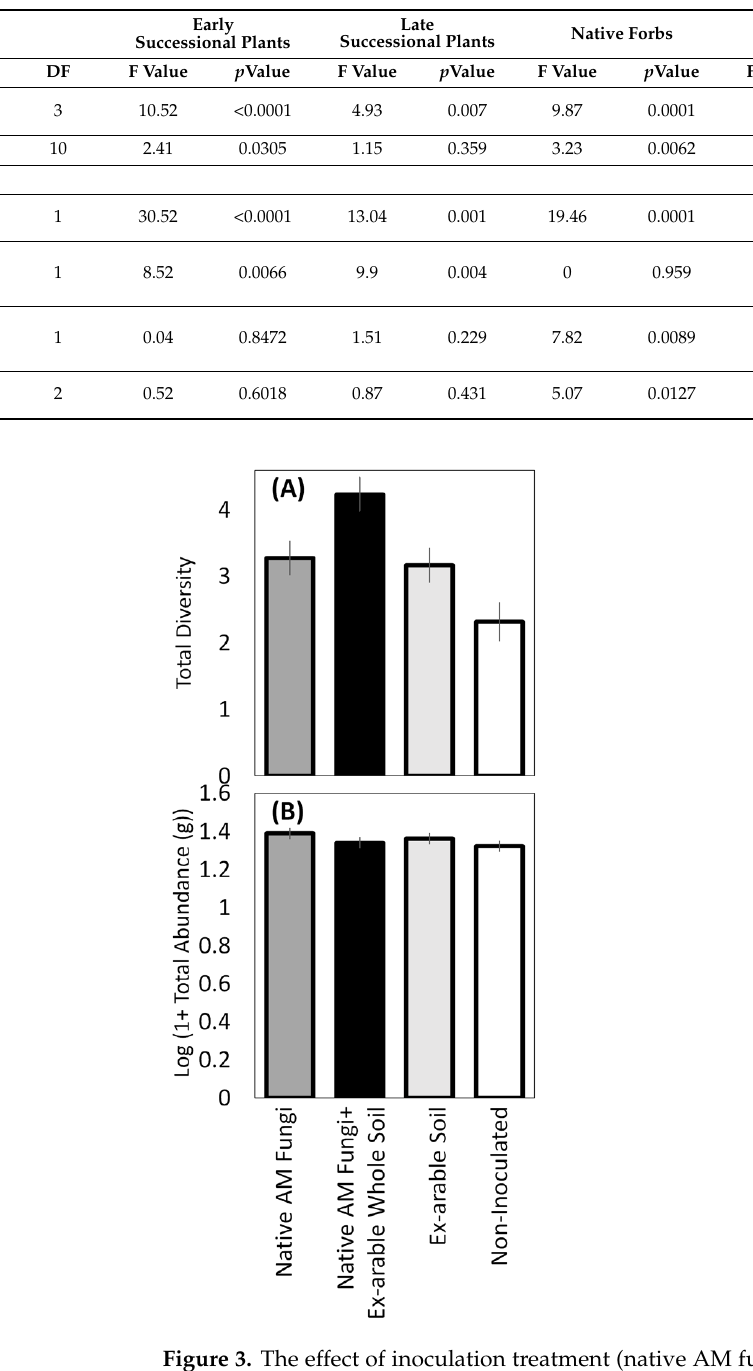
Figure 3. The effect of inoculation treatment (native AM fungi (dark grey), native AM fungi + ex- arable soil (black), ex-arable soil (light grey), and the non-inoculated control (white)) on ( A ) total plant community diversity (inverse Simpson’s index) and ( B ) total seedling biomass. Bars represent the LS means of plant aboveground biomass and error bars are standard error from the Proc GLM models.